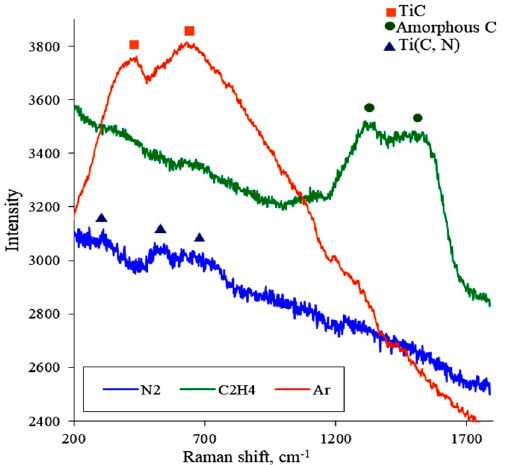
Figure 4. Coatings 2019 , 9 , 230